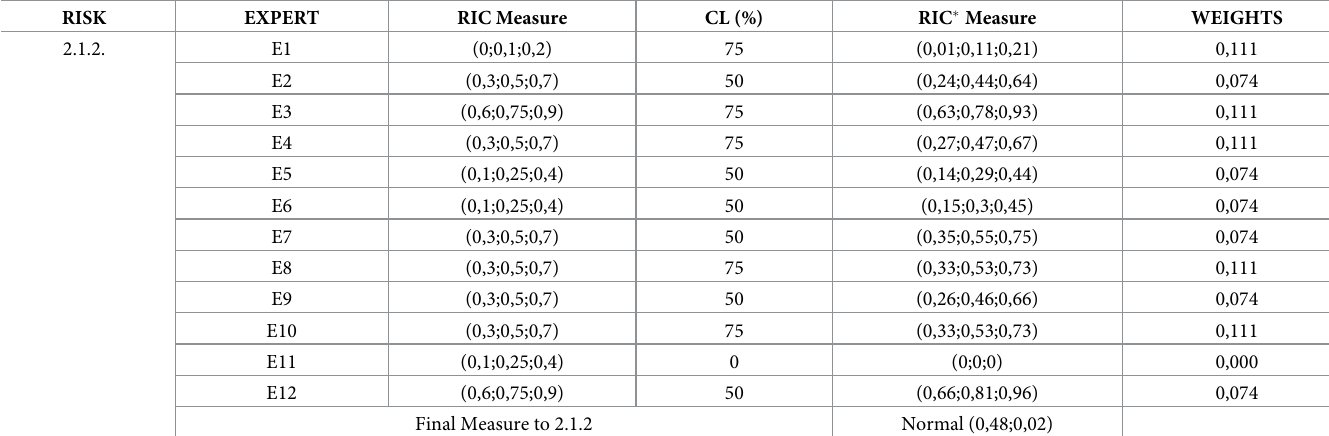
Table 4. Risk Impact on Scope: Aggregation for ‘Flood and storm risks’.